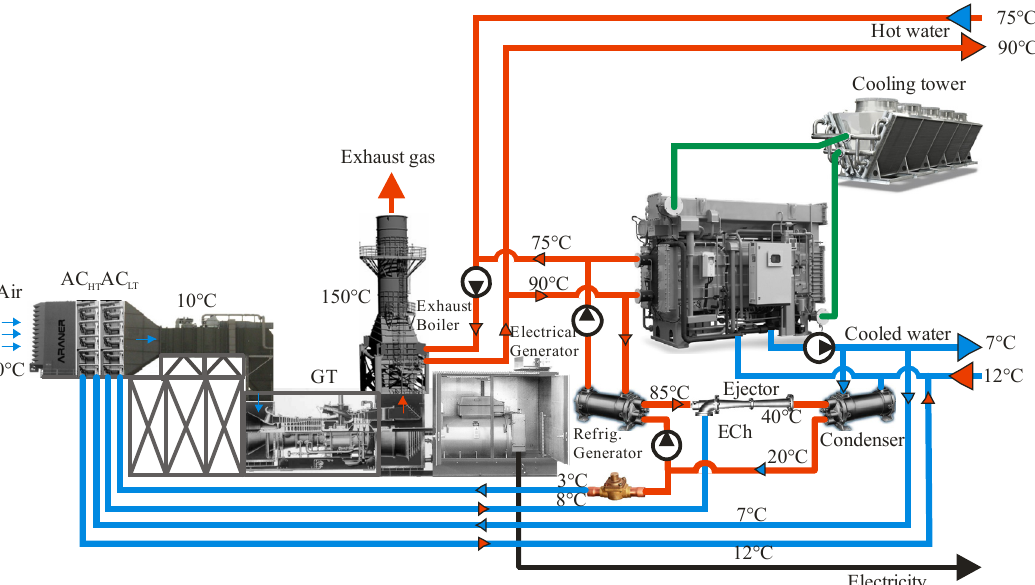
Figure 5. A scheme of two-stage gas turbine intake air cooling system in stage cascade absorption-ejector chiller (SCAECh).